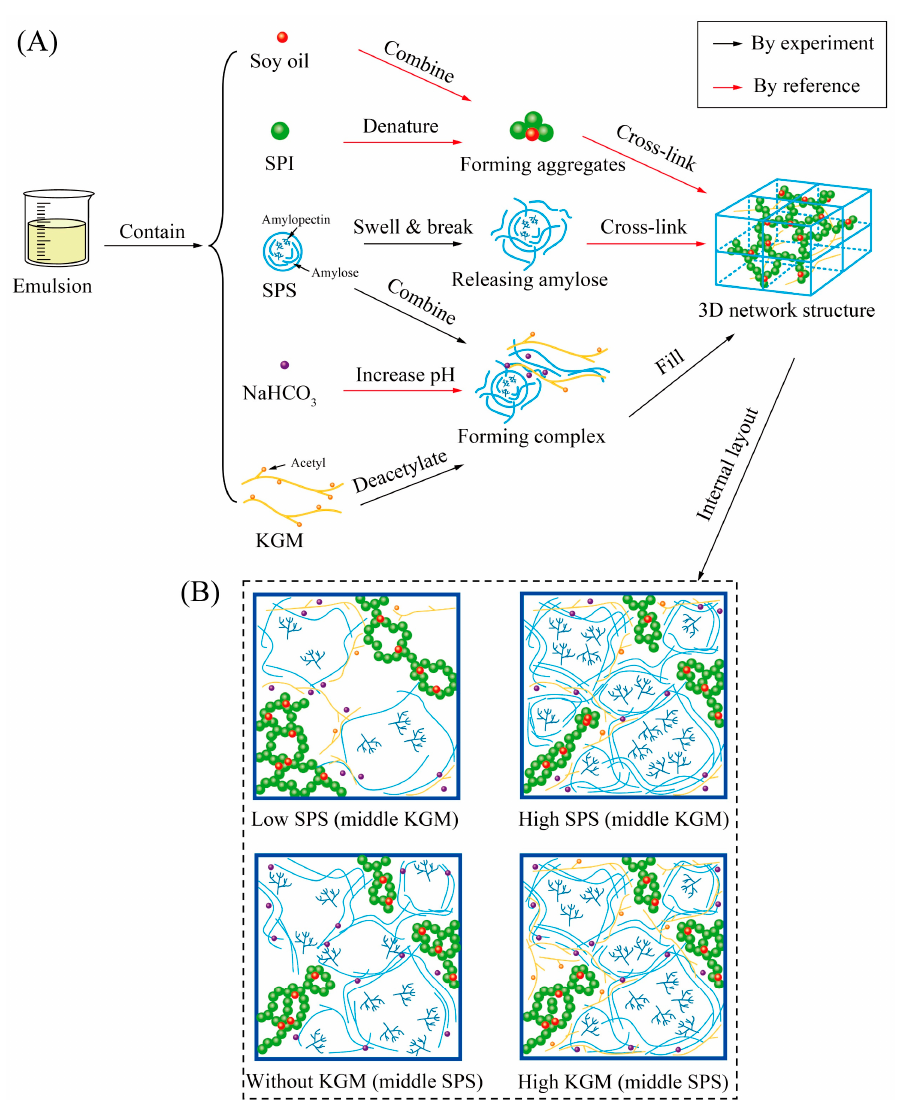
Figure 6. A schematic model showing the gelling mechanism ( A ) and internal layout ( B ) of the plant-based pork rinds containing different SPS and KGM concentrations.